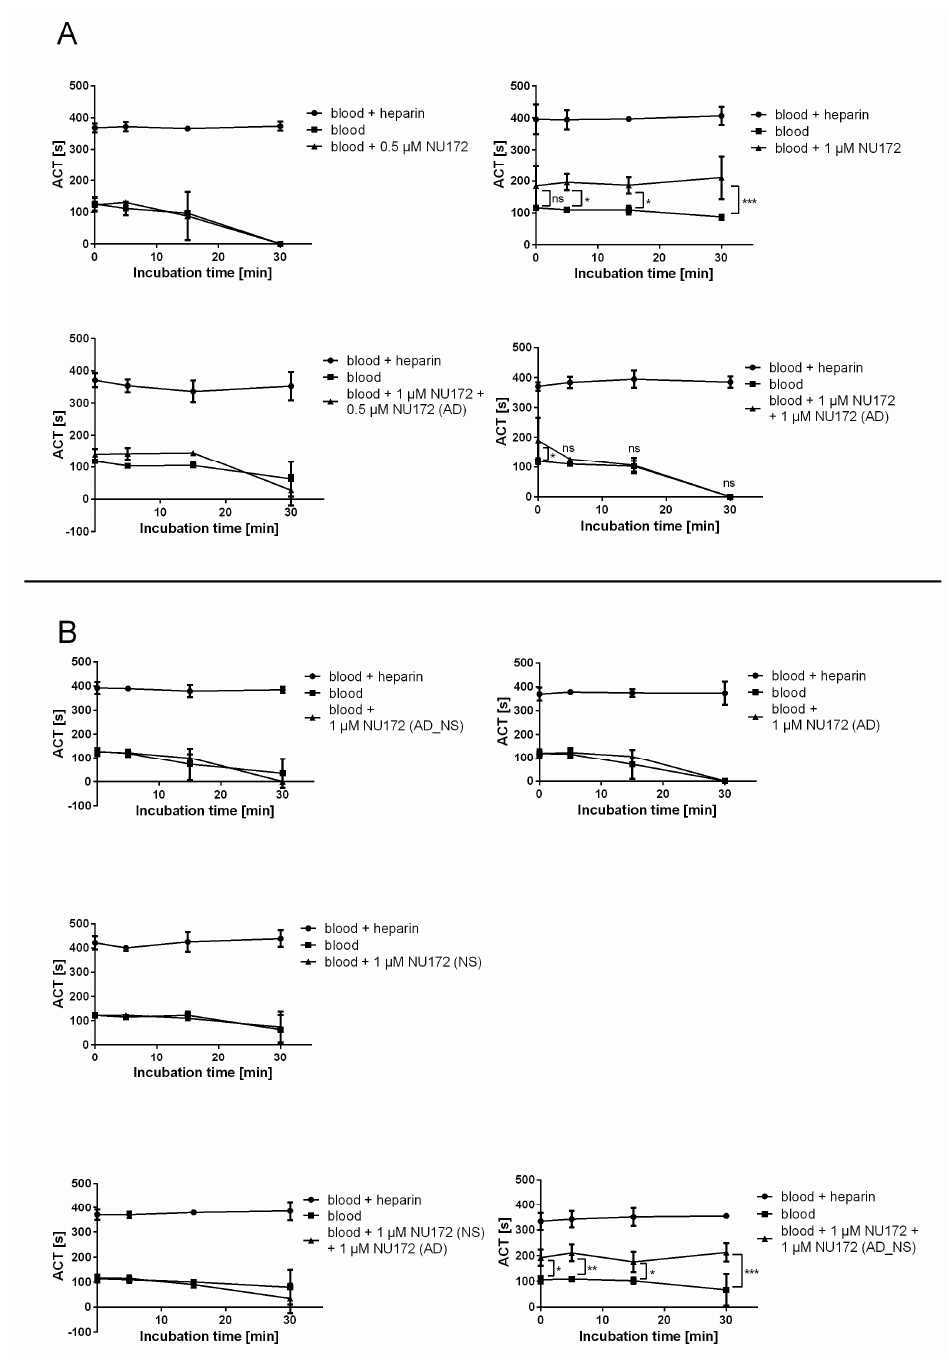
Figure 5. Measurement of the activated clotting time (ACT) of blood samples with different additives. ( A ) 0.5 μ M or 1 μ M NU172, 1 μ M NU172 and 0.5 or 1 μ M NU172 (AD), ( B ) 1 μ M NU172 (AD_NS), 1 μ M NU172 (NS), 1 μ M NU172 (AD), or 1 μ M NU172 (NS) and 1 μ M NU172 (AD), or 1 μ M NU172 and 1 μ M NU172 (AD_NS). Blood without anticoagulants was used as a negative control and blood with heparin was used as a positive control. Differences were assessed by two-way ANOVA. Results are expressed as mean ± SD ( n = 3) (* p < 0.05, ** p < 0.01, *** p < 0.001).